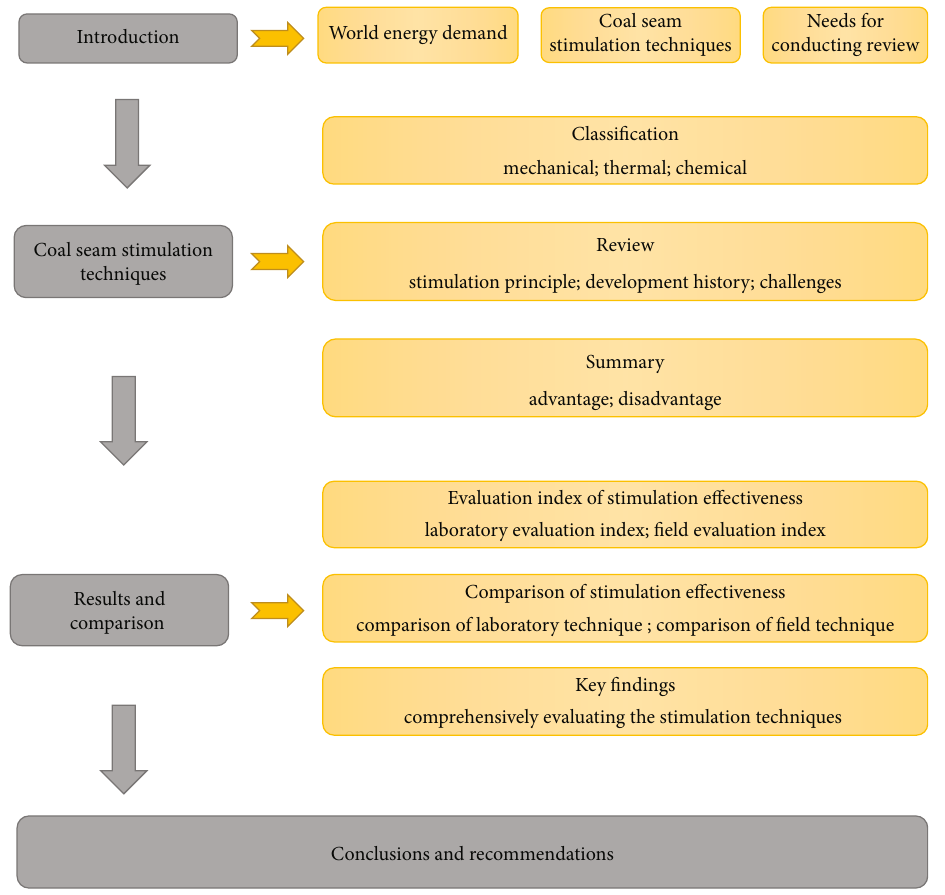
Figure 3: Organization of the